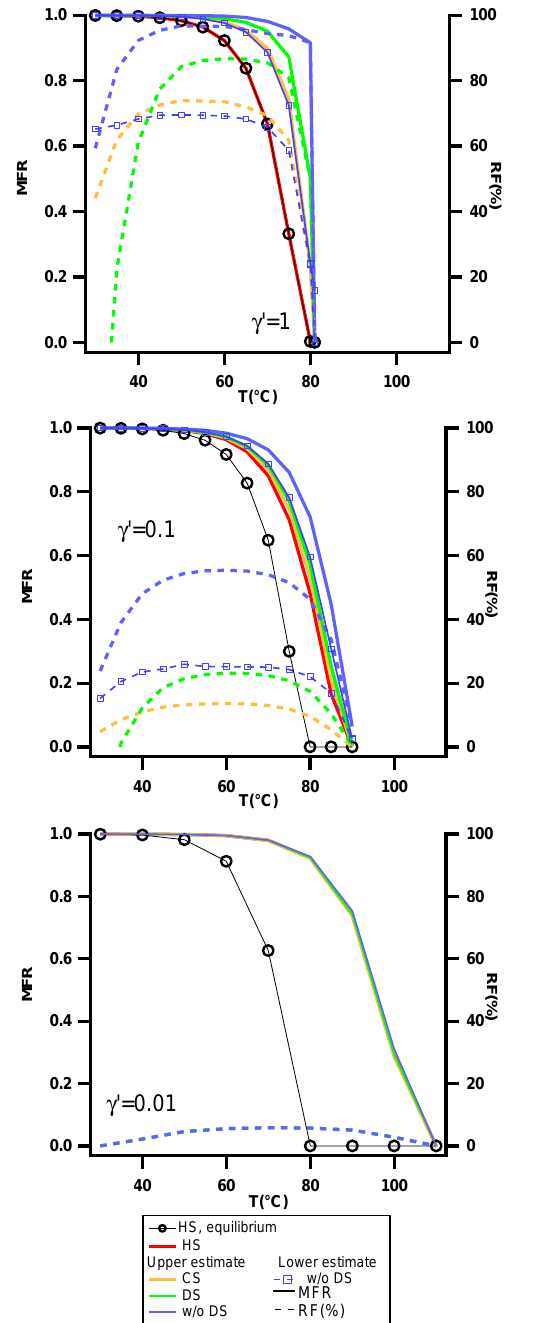
Fig. 5. Output thermograms and recondensation fraction for the heating section (HS), cooling section (CS), denuder section (DS) and equivalent configuration without denuder section (w/o DS) at different effective kinetic coefficients. Baseline case: C OA = 400µgm − 3 , C ∗ =0.1µgm − 3 , d p =100nm and D i =5e–6cm 2 s − 1 . Upper estimate: upper estimate for re-condensation (no mass trans- fer to walls); lower estimate: lower estimate for re-condensation (equilibrium wall condensation).